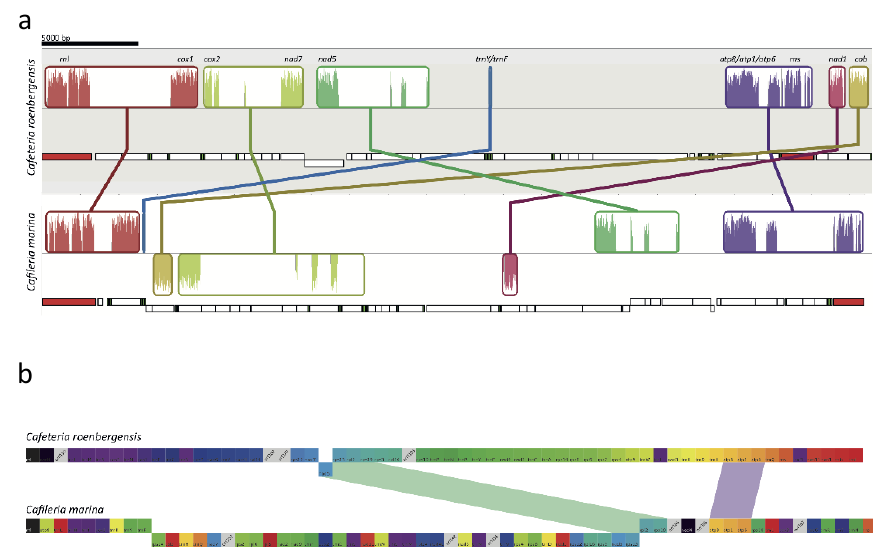
Figure 6. Collinearity of bicosoecid mitochondrial genomes. Panel ( a ) Very low level of collinearity on the genomic scale (as determined by Mauve) was observed among Cafeteria roenbergensis and Cafileria marina . Genes encoded by the plus and minus strand are depicted above or below the line representing the mitochondrial genomic sequence. Ribosomal, tRNA.; and protein-coding genes are schematically shown in red, green, and white, respectively. Gene-level collinearity Panel ( b ) is also very low, corroborating the numerous genomic rearrangements seen on the genomic level.